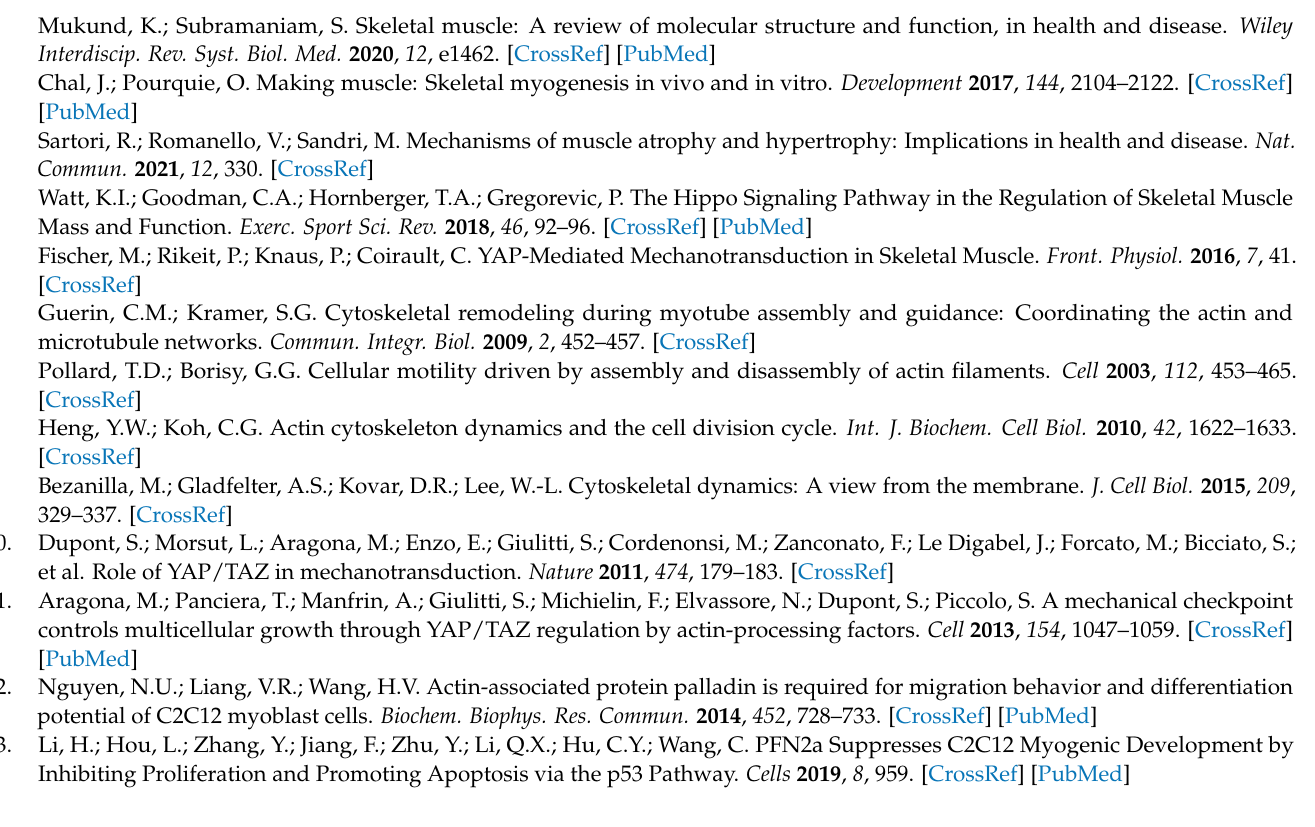
Table S2: Primer lists and conditions for q RT-PCR, Table S3: Antibodies